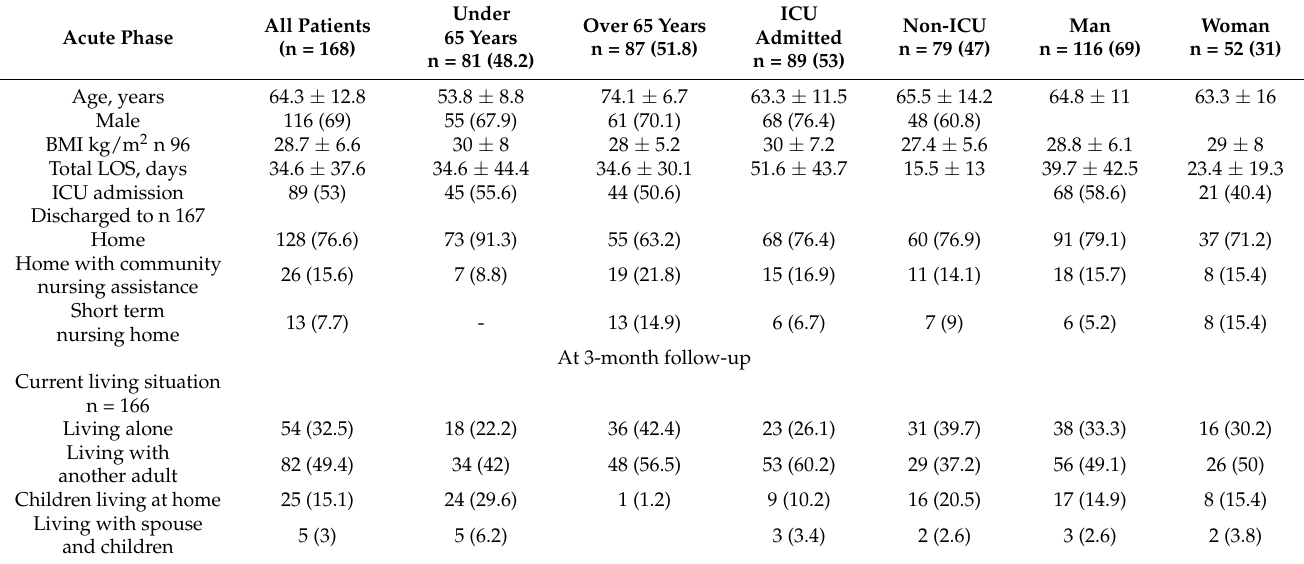
Table 1. Patient characteristics, at acute phase and at 3-month